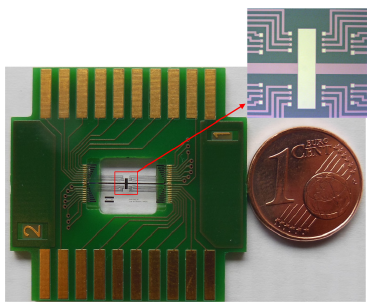
Fig.1: The image of a packaged electrode chip with double side PCB suitable for the multiplexer and the insert image which enlarged microelectrode